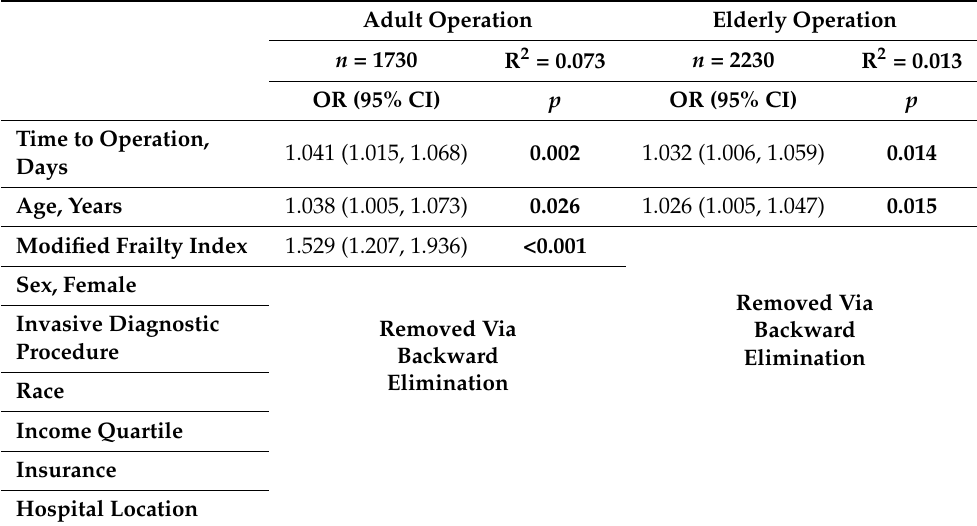
Table 5. Backward multivariable logistic regression analysis to evaluate the associations between mortality and different factors in emergency-admitted patients with the primary diagnosis of paralytic ileus and undergoing an operation (NIS 2005–2014). Mortality was the dependent variable.